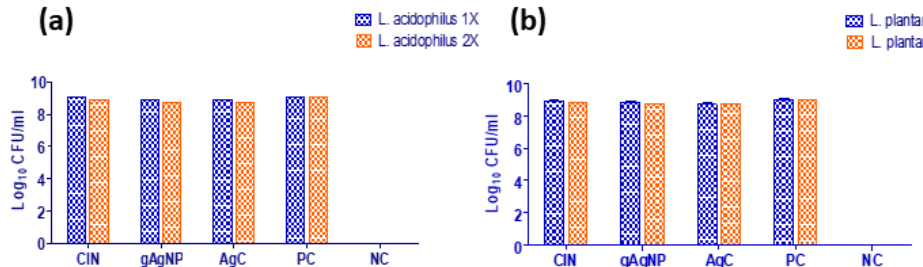
Figure 3. In vitro antimicrobial effect of cinnamaldehyde (CIN), AgNPs and AgC (1X and 2X) on commensal gut lactobacilli. Untreated L. acidophilus ( a ) and L. plantarum ( b ) served as positive growth control (PC), while media (MRS broth) served as negative control (NC).